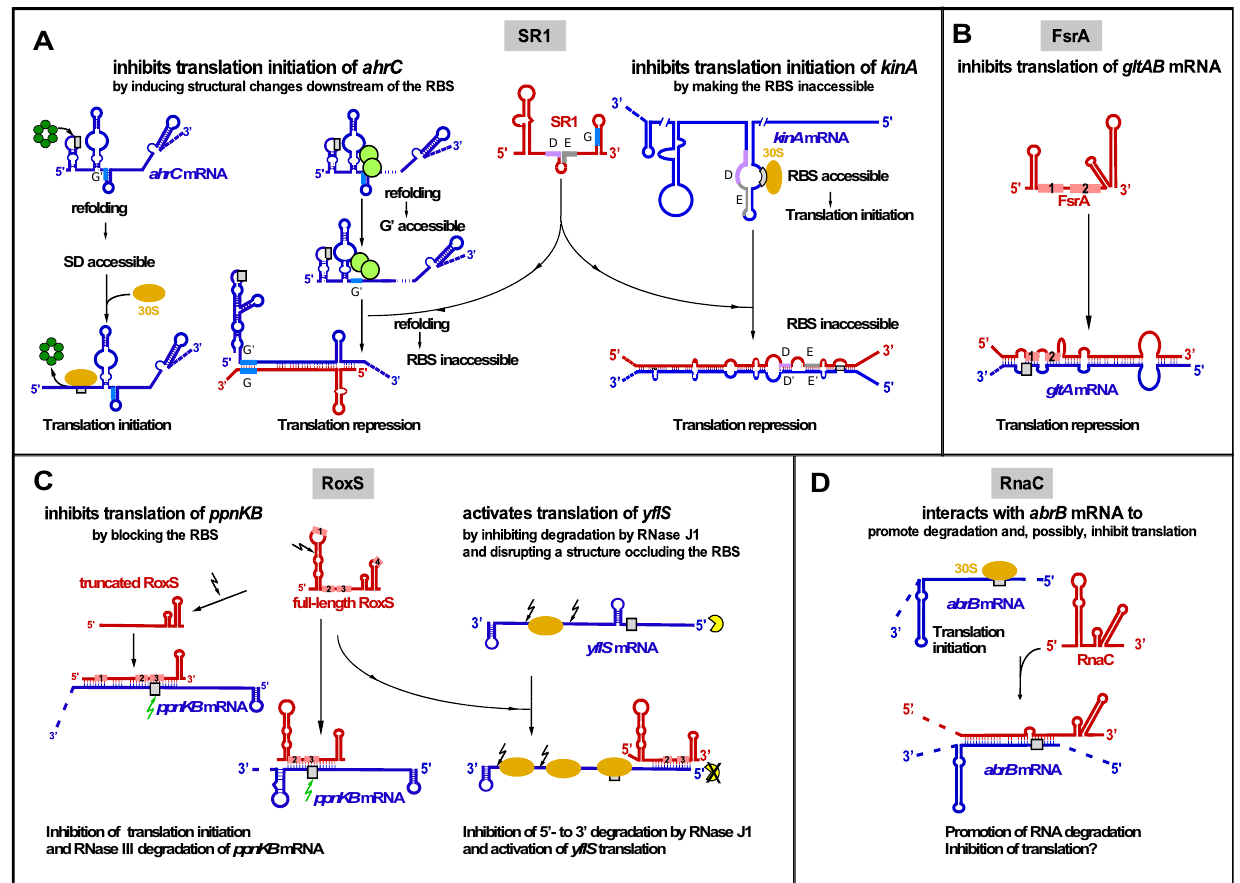
Figure 2. Interactions of the currently known trans -encoded sRNAs with their target mRNAs. ( A ) Left half: SR1 interacts with ahrC mRNA about 100 nt downstream of the RBS, which induces structural changes around the ahrC RBS that inhibit translation initiation. Hfq (dark-green) binds immediately upstream of the ahrC RBS (grey rectangle) to make it accessible to the 30S SU. By binding to GGA motives 1 – 3 of ahrC mRNA, CsrA (light-green) induces a slight structural change that makes region G’ (turquois) accessible to complementary region G of SR1. SR1 binding causes a structural change that renders the ahrC RBS inaccessible to 30S binding, thereby inhibiting translation initiation [45,46] (based on [4]). Right half: SR1 inhibits translation initiation of kinA mRNA by occluding the kinA RBS. The initial SR1 – kinA mRNA interaction occurs between complementary regions D/D’ (violet) followed by the interaction between complementary regions E/E’ (grey). ( B ) Interaction of FsrA with gltAB mRNA. FsrA has numerous targets, but in vivo base-pairing has only been shown for gltAB mRNA. Most probably, FsrA inhibits translation of all targets (see Table 2). The two C-rich regions (CRR) are highlighted in pink. ( C ) Interaction of RoxS with two target mRNAs. Whereas RoxS and its truncated derivative repress ppnKB translation, full-length RoxS activates yflS translation, both by disrupting a structure occluding the RBS and by inhibiting RNase J1 degradation from the 5′ end. RoxS interacts with i ts targets via CRR’s (shown in pink), CRR3 was found to be decisive. ( D ) Interaction of RnaC with abrB mRNA, which promotes RNA degradation and, most probably, inhibits abrB translation. Red, sRNAs; blue, target mRNAs; beige oval, 30S SU; grey box, RBS; green arrow, RNase III; black arrow, RNase Y; yellow, RNase J1.